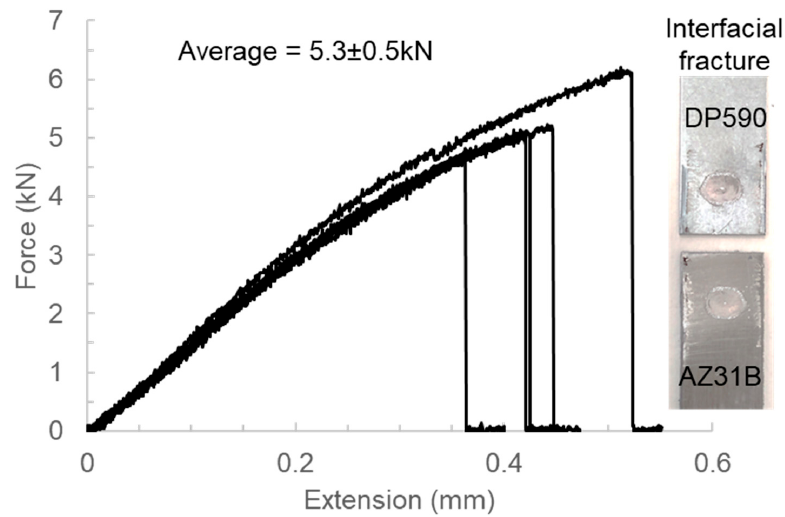
Figure 4. Lap shear tensile load vs. extension curves measured on the weld coupons that were produced in Experimental Setup 2 condition as listed in Table 1. The inserted image shows the interfacial fracture occurred on one of the coupons.